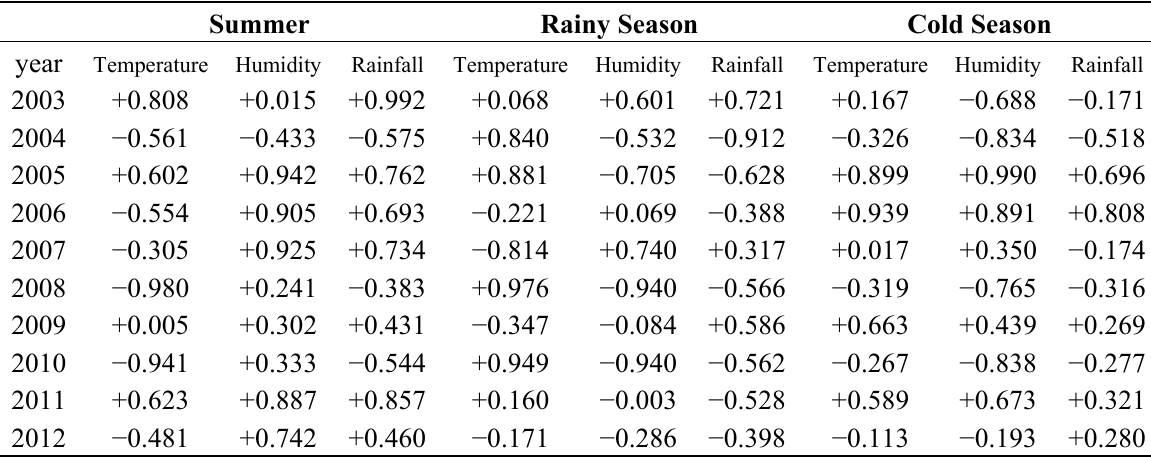
Table 2. Pearson’s correlations between climatic factors and HFMD infection rates by